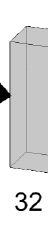
Figure 4. The network architecture with simulated data. The artificial data has 6 which can be arranged in a grid structure with shape of 6 By passing this window from the top left corner of the original 6 5 5 matrix. The number 32 is the number of units in the hidden layer. In this example, there is one × hidden layer, which is sufficient for the dimension of the data in the example. Table 2. The steps of the backward dropping algorithm in a 2